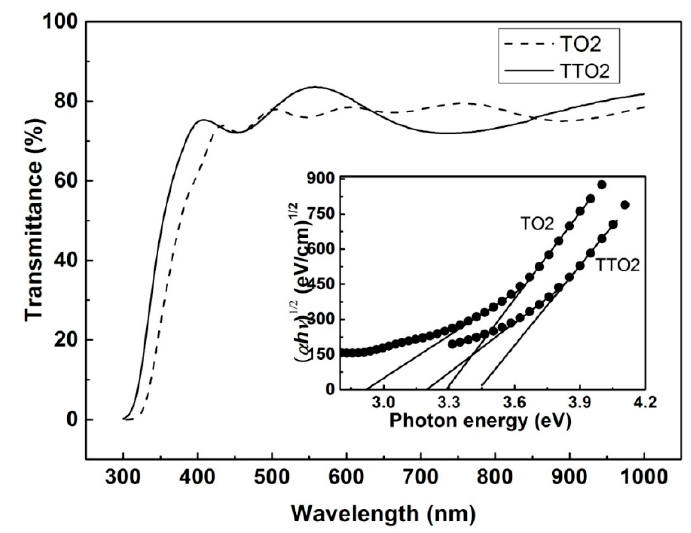
Figure 4. Optical transmittance spectra of TO2 and TTO2. The inset shows the plots of ( α h ν ) 1 / 2 against h ν .